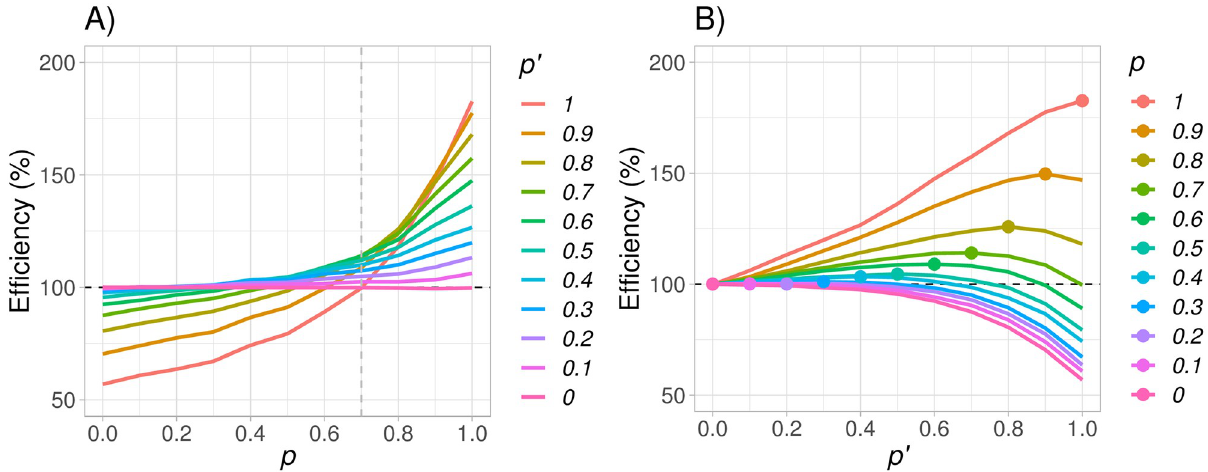
Fig 9. Efficiency between the modified weighted log-rank ( mWLR ) test and the log-rank ( LR ) test assuming a fixed value of m OS varying both p and p 0 between 0 and 1. Values above 100% favor mWLR and values below 100% favor LR .